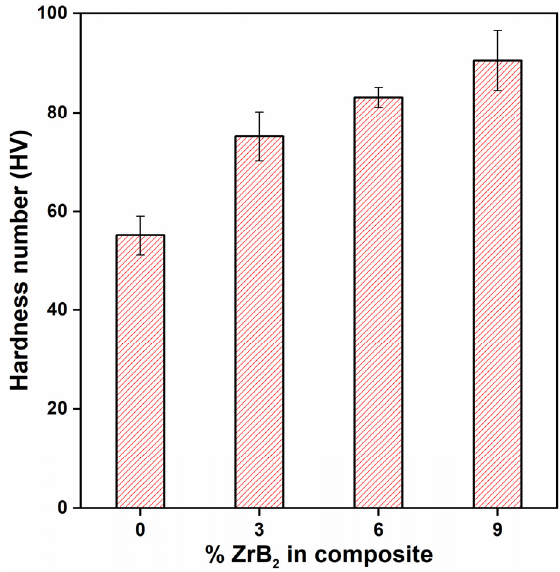
Figure 4. Microhardness of ADC12/ZrB 2 in-situ composite.